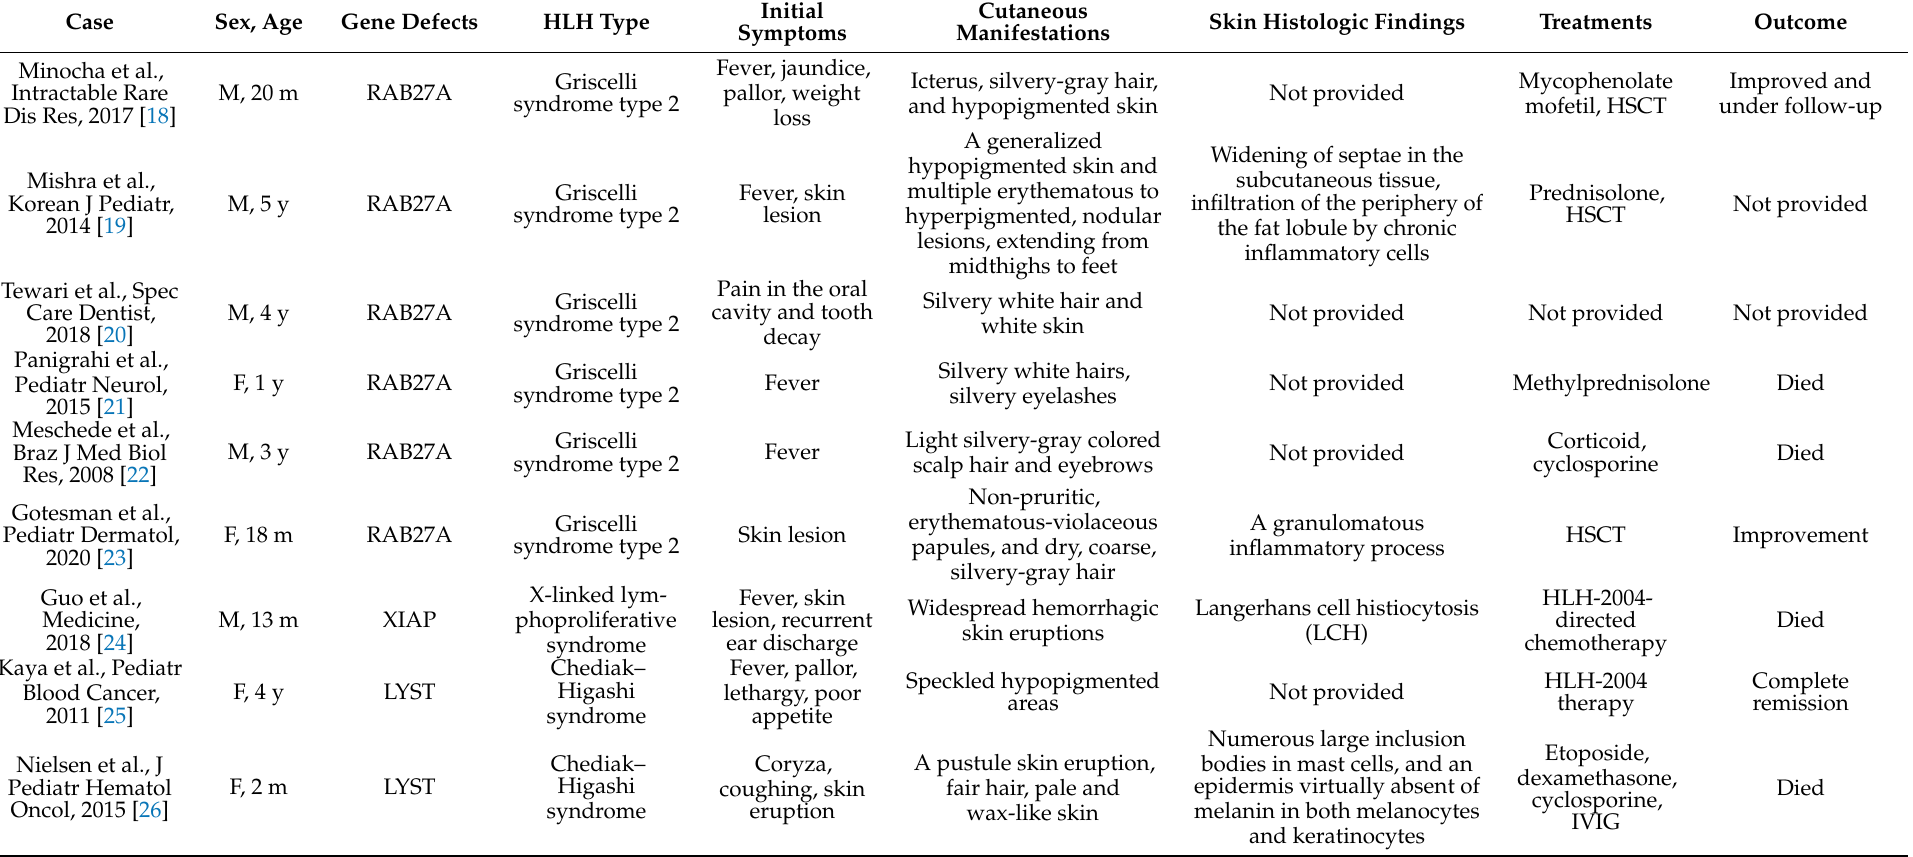
Table 3. Primary HLH with cutaneous